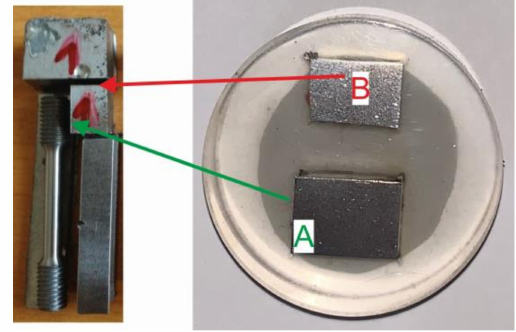
Figure 6. Metallographic cut in longitudinal direction (area A) and transverse direction (area